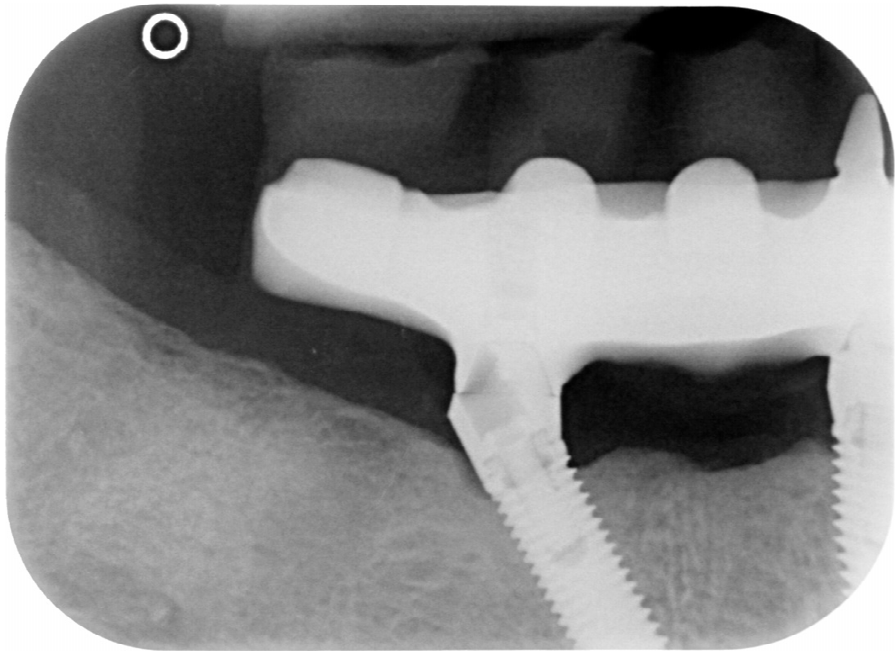
Figure 14. X-ray of 4.5 dental implant in patient in 6 months after treatment.